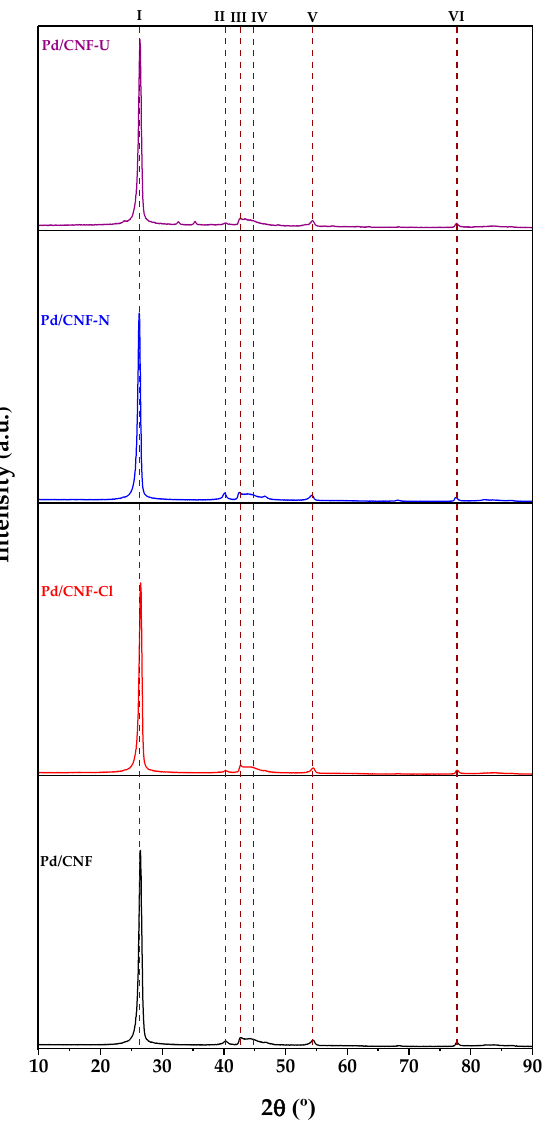
Figure 1. Distribution of Pd NP size on different catalysts (( a ) Pd/CNF; ( b ) Pd/CNF-Cl; ( c ) Pd/CNF- N; ( d ) Pd/CNF-U).